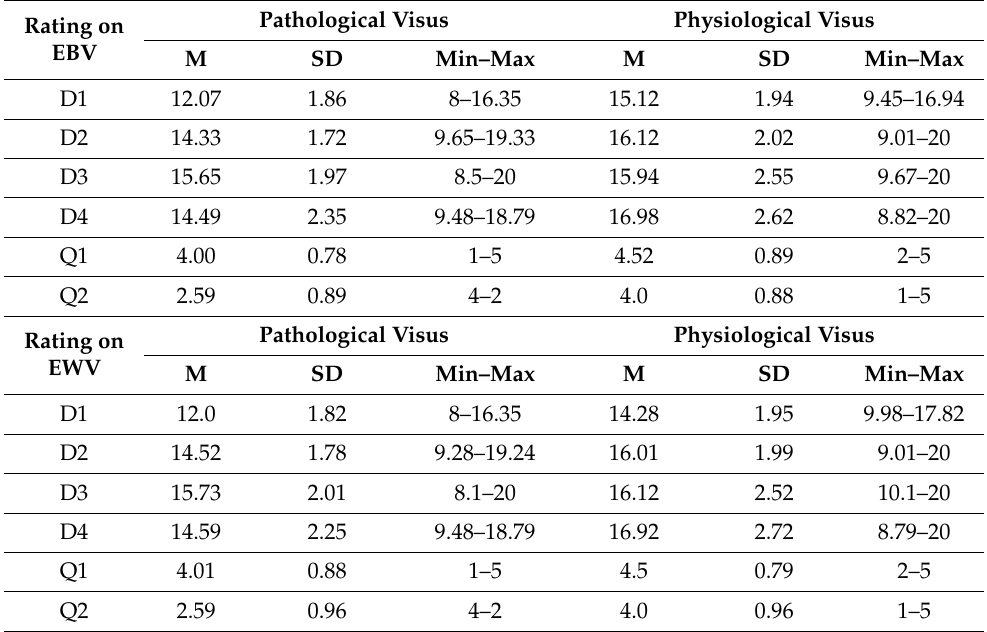
Table 5. Differences in the means of the domains of the researched groups in terms of physiologi- cal/pathological